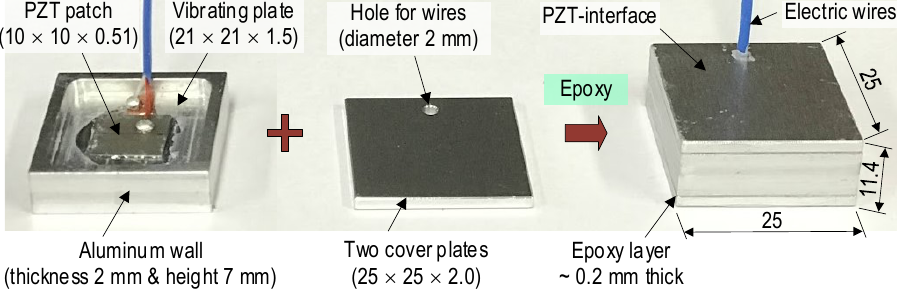
Figure 10. PZT interface device tested for calibration of impedance monitoring system ‘SSeL-Pi’. (dimension in mm).